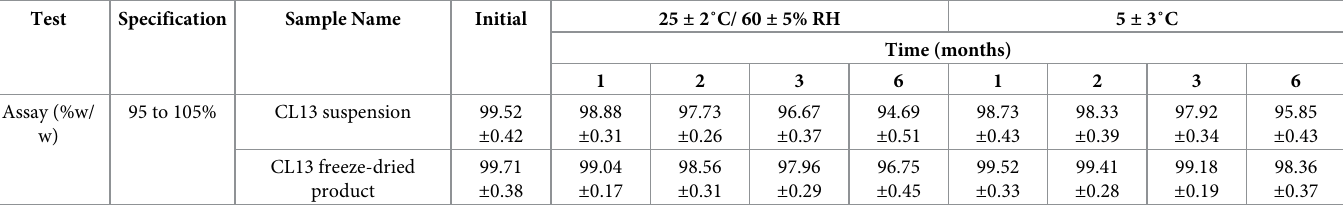
Table 3. Comparative stability profile of liposomal suspension and freeze-dried form of CL13 formulation as per ICH guidelines.